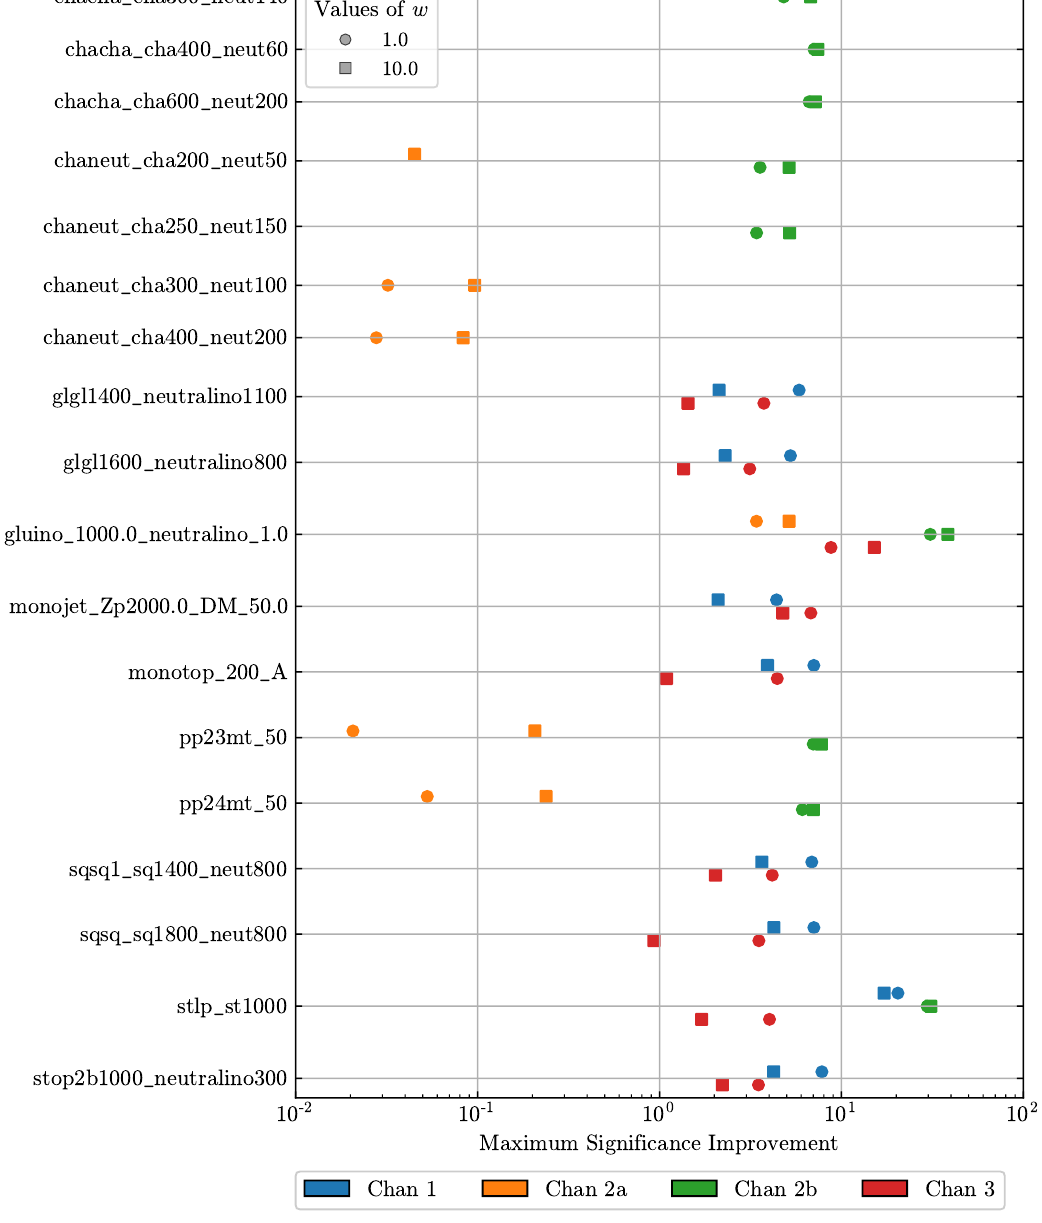
Figure 7: Significance improvements of the BSM signals for the models using β = 1.0. The maximum significance improvement over three anomaly score cuts are displayed for each channel. The circle and squares mark the networks with w = 1.0 and w = 10.0, respec- tively. However, w does not enter into the loss when β = 1, so the spread between the results can be viewed as a training